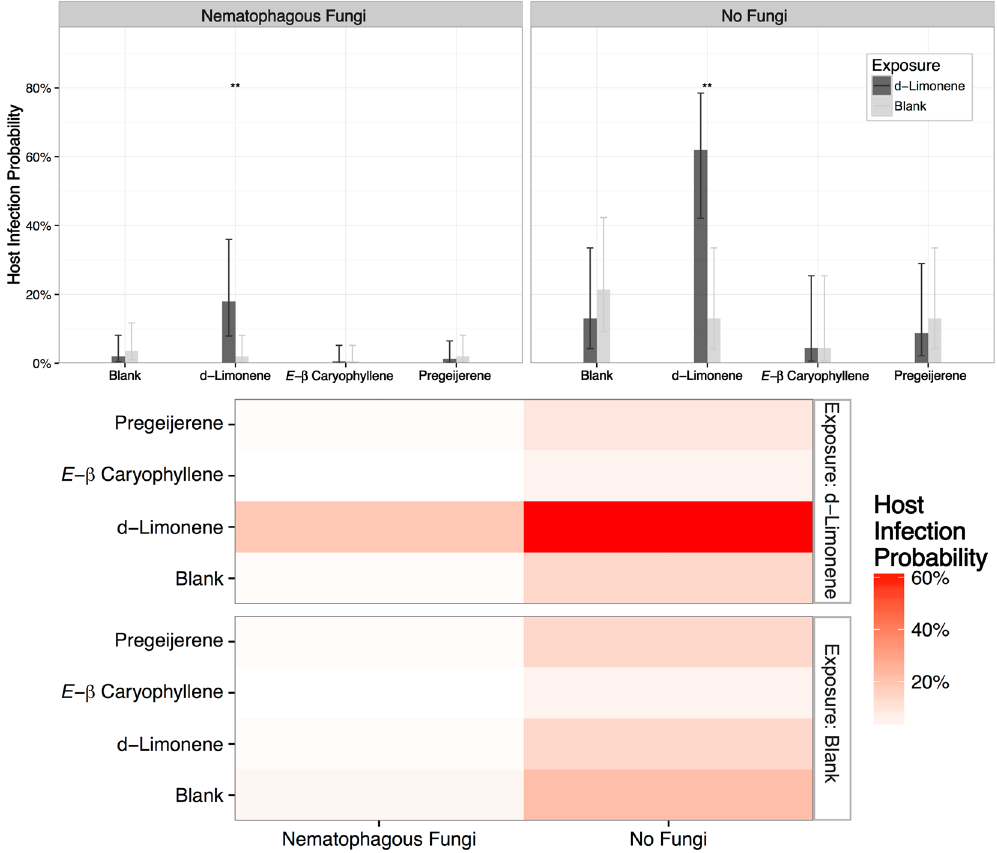
Figure 4. Parasitoid Learning Affects Predation. Prior exposure to d-limonene increases host infection probability despite predation by nematophagous fungi. Cohorts of entomopathogenic nematode H . indica infective juveniles were exposed to blank controls or d-limonene then assayed in the presence and absence of the nematophagous fungal predator A . dactyloides . Bars and error bars denote host infection probability and ninety-five percent confidence intervals respectively. Double asterisks denotes significant enhancement of infection probability at P <